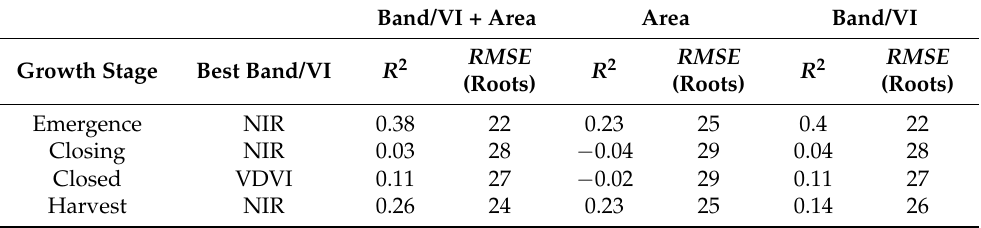
Table 4. Table beet root count growth stage and band/VI assessment report with leave-one-out cross-validation R 2 and root mean squared error (RMSE) for the best pairing of a radiometric feature